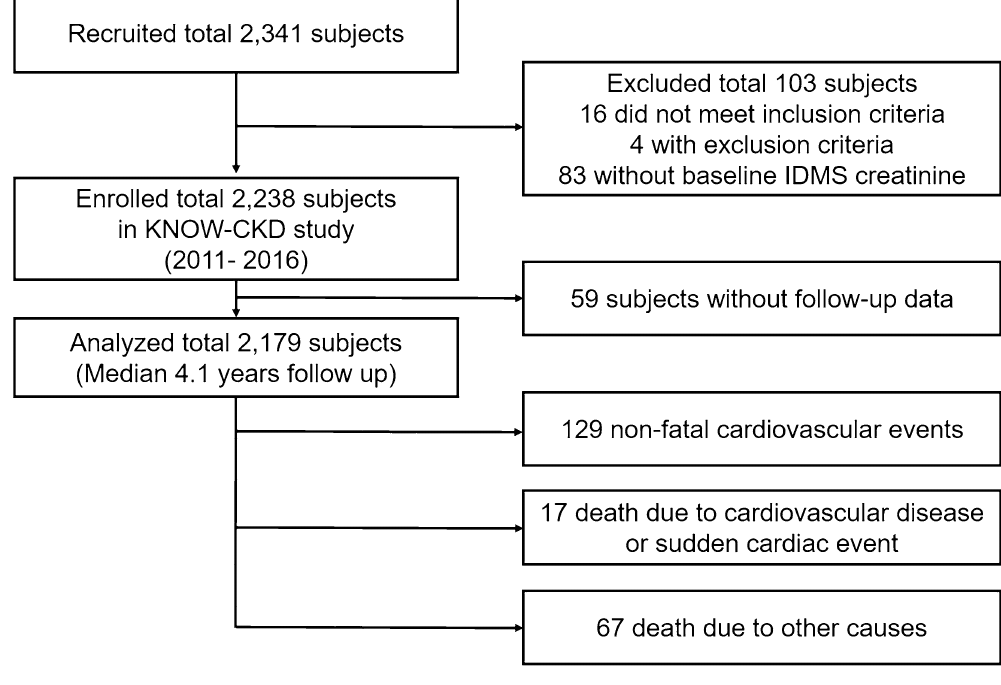
Figure 1. Flowchart of the enrolled study